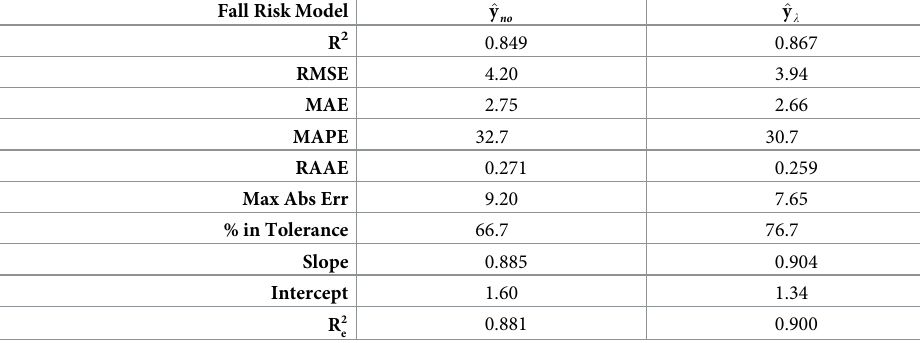
Table 5. Summary statistics for the fall risk models using data from the Markov chains. R 2 gives the adjusted R 2 value for the fitted model (Eq 12). The root mean squared error (RMSE), mean absolute error (MAE), mean absolute percentage error (MAPE), relative average absolute error (RAAE), and maximum absolute error (Max Abs Err) are over all training conditions. The % in Tolerance indicates the percentage of these trials in which the predicted value was within ln(MFPT) ± 3.3. The slope, intercept, and R 2 are from Eq 15. Values of 1, 0, and 1, respectively, would indi- e cate a perfect